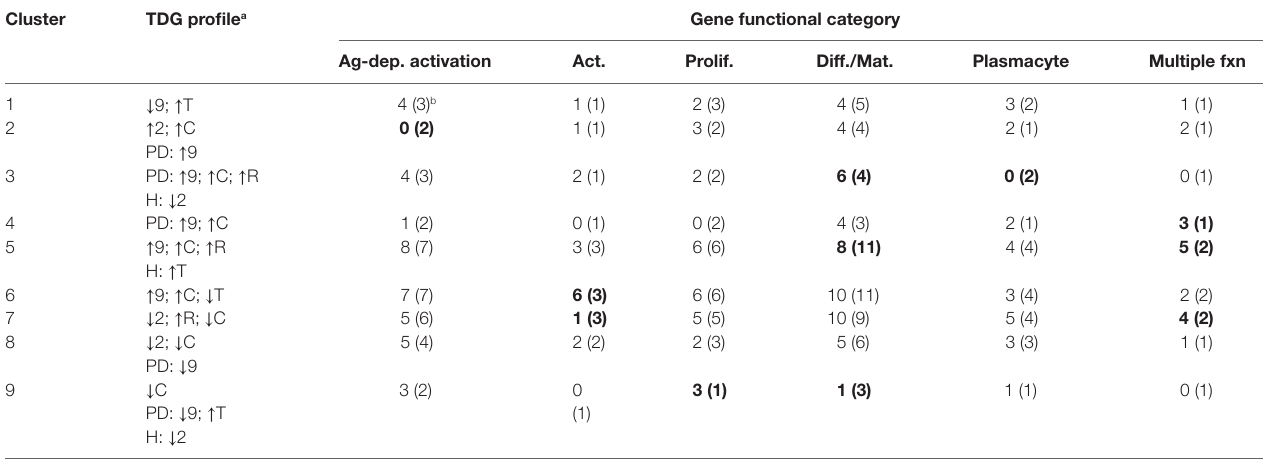
b Numbers denote frequency of genes observed in individual clusters and number of genes expected based on total genes representing that function (parentheses). Those highlighted in bold indicate altered distribution.